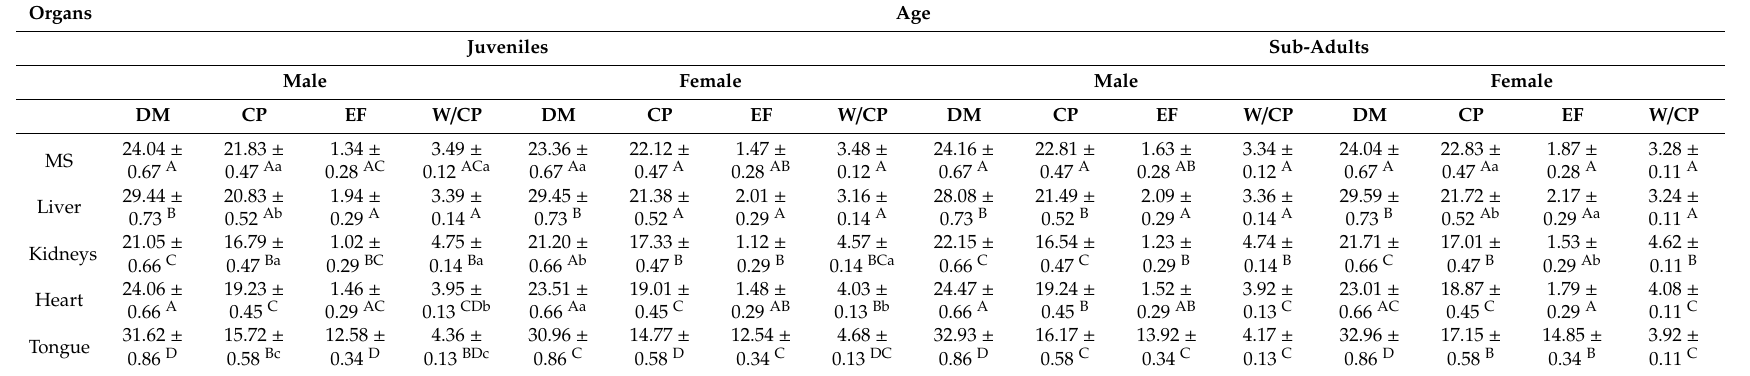
Table 6. The proximal chemical composition of muscle and o ff al from the wild boar (mean ±